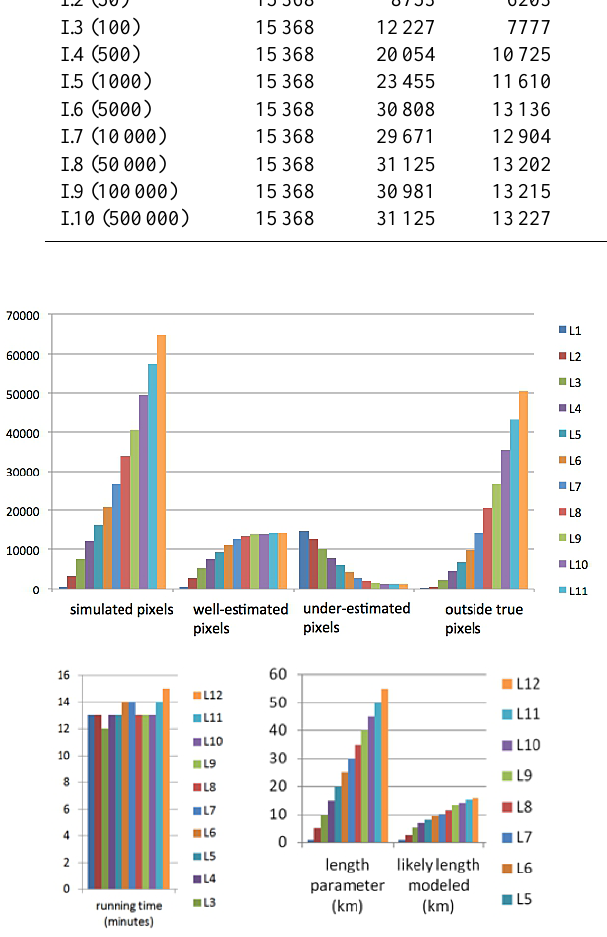
Figure 3. Sensitivity of the length parameter for the simulation of the 2010 lava flow of Nyamulagira. (From L1–12 simulations of 1, 5, 10, 15, 20, 25, 30, 35, 40, 45, 50, and 55km length, respectively).